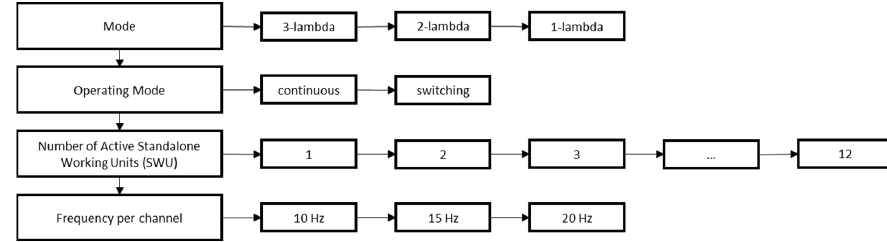
Figure 3. Adjustability of illumination device.